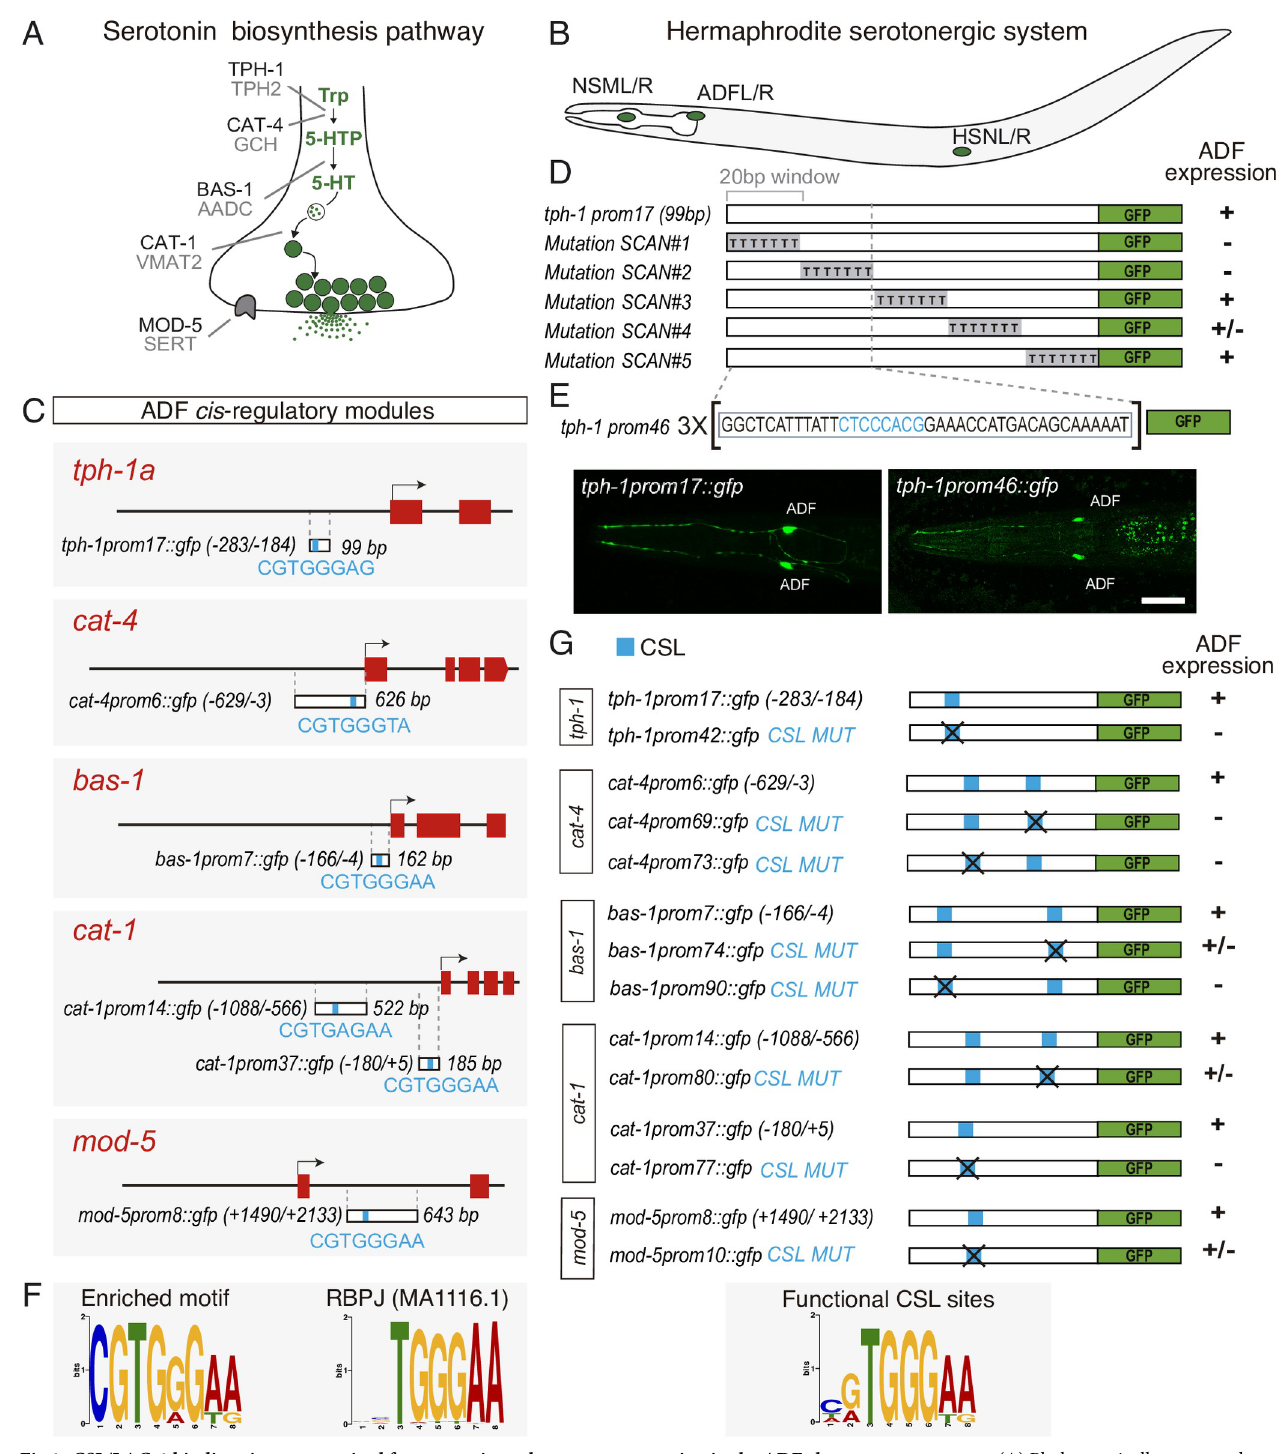
Fig 1. CSL/LAG-1 binding sites are required for serotonin pathway gene expression in the ADF chemosensory neuron. (A) Phylogenetically conserved serotonin biosynthetic pathway. C . elegans protein names appear in dark font, mammalian in grey. (B) C . elegans hermaphrodite serotonin synthesising system is composed of 3 types of bilateral neurons (NSM, ADF, and HSN, L: left, R: right). (C) 5HT pathway gene minimal CRMs active in ADF neurons. The most significant overrepresented motif shared by all CRMs is depicted in blue. Numbers in brackets represent the coordinates of each construct referred to the translational start site. Red boxes represent coding exons. (D) Scanning mutation analysis of tph-1 minimal CRM unravels the functionality of the first 40 bp. Sequence windows of 20 bp were mutated to poliT. +: > 80%; +/ − : 80%–20%; − : < 20% of mean wild type expression values. See S1 Fig for raw data. (E) Young